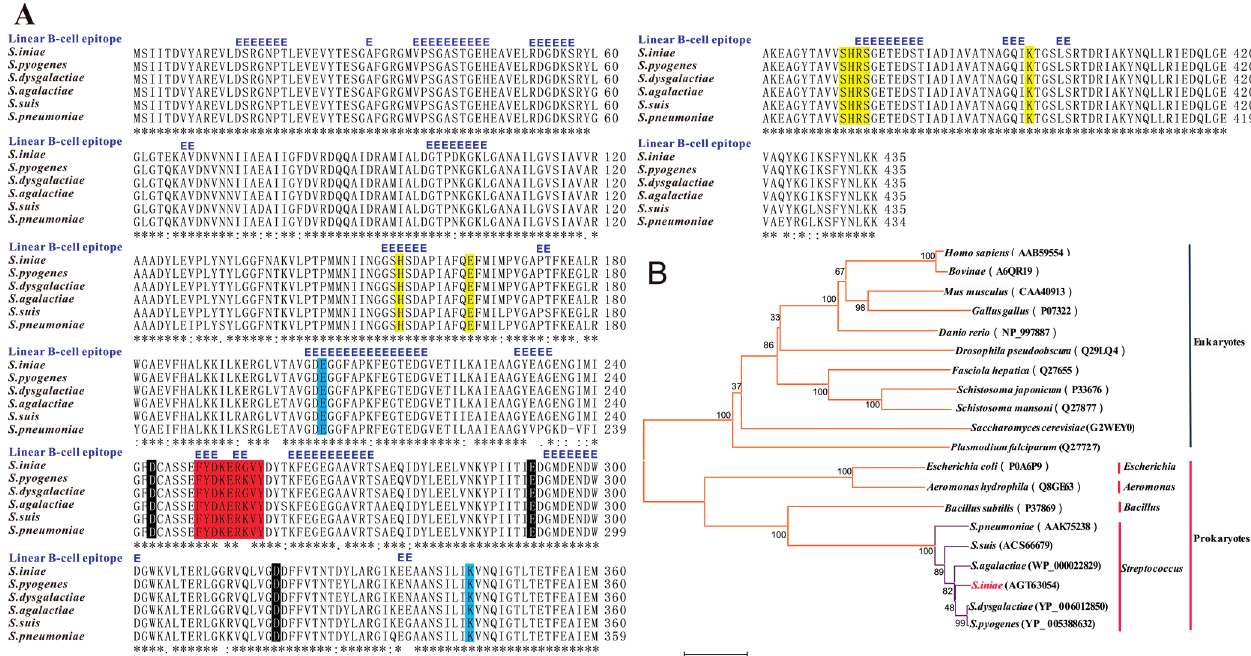
Figure 1. Multiple sequence alignments and phylogenetic analysis of S. iniae α -enolase with homologous enolase. ( A ) Alignment of the deduced amino acid sequence of S. iniae α -enolase (AGT63054) with those of homologous α -enolase from other Streptococcus . These α -enolase sequences were used from S. dysgalactiae (YP_006012850; 98%), S. pyogenes (YP_005388632; 97%), S. agalactiae (WP_000022829; 97%), S. suis (ACS66679; 95%), S. pneumoniae (AAK75238; 93%), and aligned using the ClustalW2 program. Regions of identity (*), strong similarity (:) and weak similarity (.) were indicated. The putative plasminogen-binding regions were shaded in red. The residues involved in enzyme active sites (205 E, 343 K), metal-binding sites (242 D, 291 E, 318D; magnesium), substrate-binding sites (155 H, 164 E, 291 E, 318 D, 343 K, 370-373 SHRS, 394 K) were shaded in blue, black and yellow, respectively. But there were no any signal peptidase cleavage site or membrane-spanning domains in the amino acid sequence. A residue annotated with a blue “E” was predicted as being part of a linear B-cell epitope (score above threshold 0.7); ( B ) The tree of the α -enolases from the Streptococcus of above, some other prokaryotes and eukaryotes was constructed by the neighbour-joining method and plotted with MEGA 4.1. Evolutionary distances were computed using the Poisson correction method. Branch support values (10,000 bootstraps) for nodes were